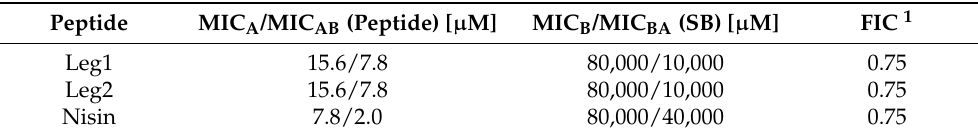
Table 2. Results of the checkerboard assay of Leg1/Leg2/nisin and sodium benzoate (SB) against B. subtilis displaying MIC A /MIC B (MIC for the peptide or SB), MIC AB /MIC BA (MIC for the combi- nation of peptide and SB) and fractional inhibitory concentration (FIC)